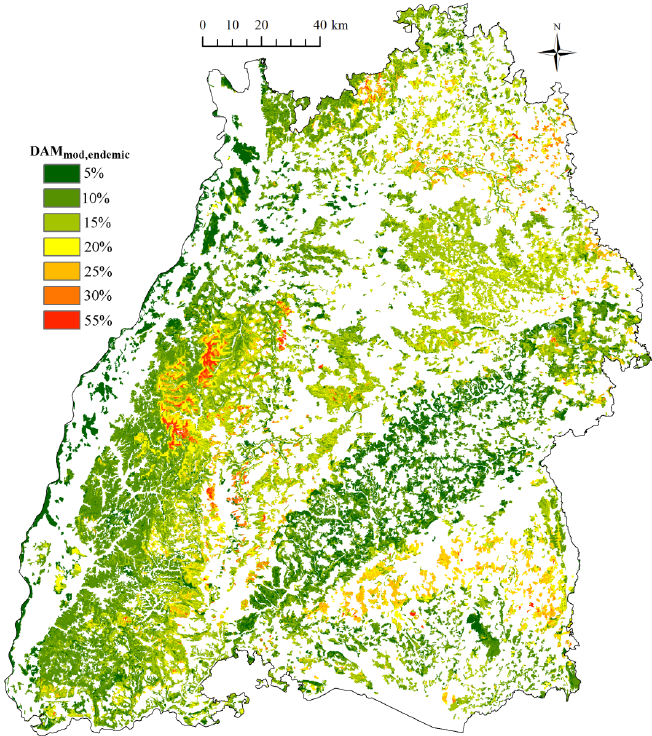
Figure 15. Map of modeled proportions of endemically storm-damaged timber ( DAM mod,endemic ). The legend values indicate highest class values.